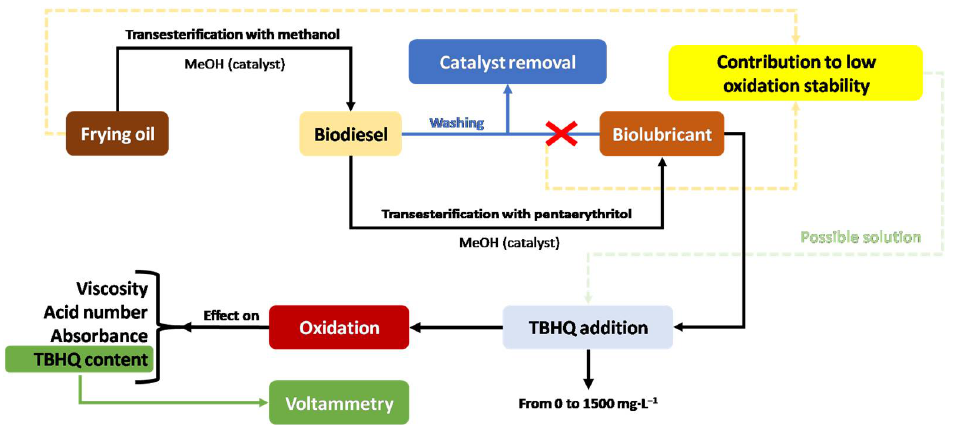
Figure 19. Experimental design for this work.